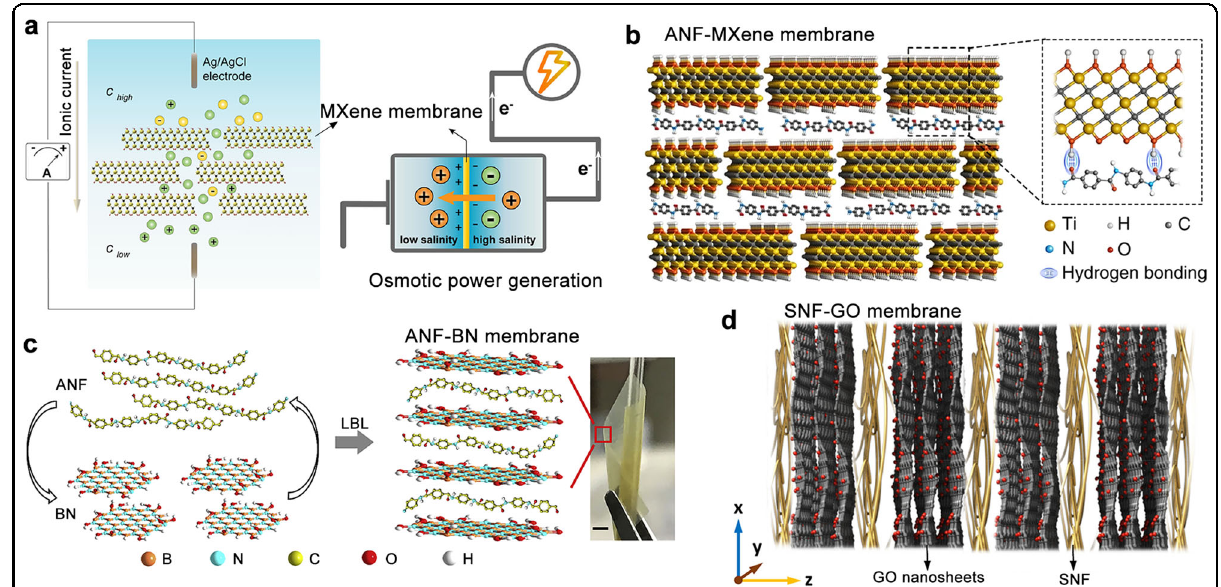
Fig. 7 Hierarchical nanochannel membranes based on 2D materials. a Lamellar membrane from the stacking of sole Ti 3 C 2 T x MXene nanosheets and schematic of osmotic energy generation. Reproduced with permission 60 . Copyright 2019, American Chemical Society. b Schematic of the structure of the ANF-MXene composite membrane. Reproduced with permission 64 . CC BY 4.0 (https://creativecommons.org/licenses/by-nc/4.0/). c Schematic of the preparation of the ANF-BN composite membrane by the LBL assembly method. Reproduced with permission 65 . Copyright 2019, Elsevier d Schematic of the multilayer structure of the SNF-GO composite membrane. Reproduced with permission 67 . Copyright 2020, American Chemical